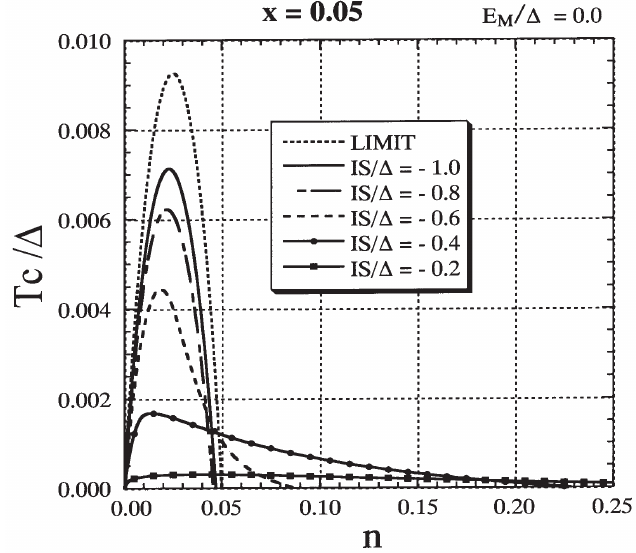
Figure 9. The result for Curie temperature T n for various values of IS= ∆ with x = 0 : 05 and E the assumption that an impurity band has the same shape as the model DOS is drawn as ‘LIMIT’ (see text). From Takahashi and Kubo